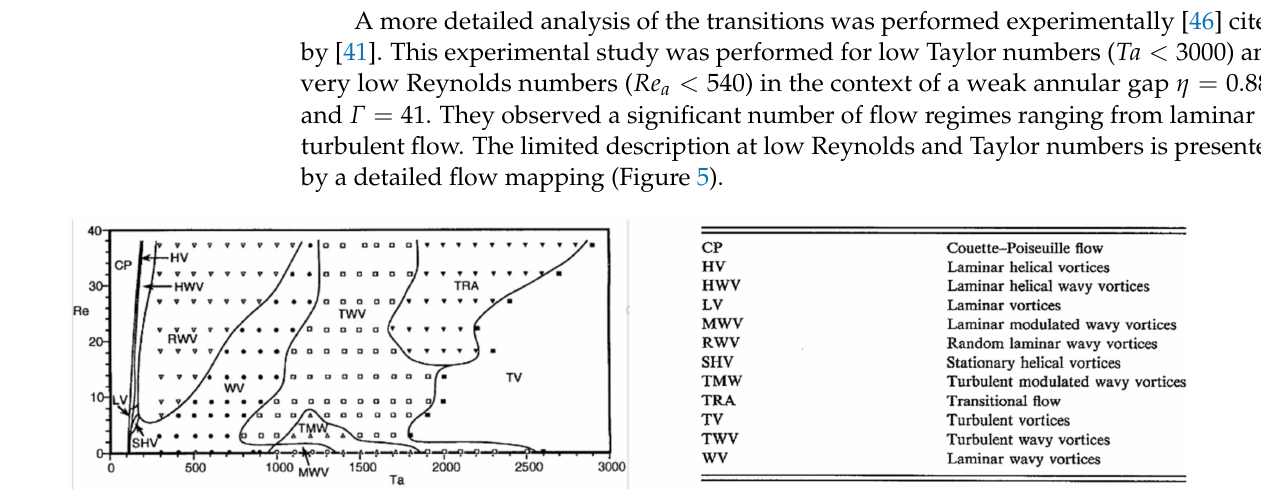
Figure 5. Different transitions of the Taylor–Couette–Poiseuille flow [41].